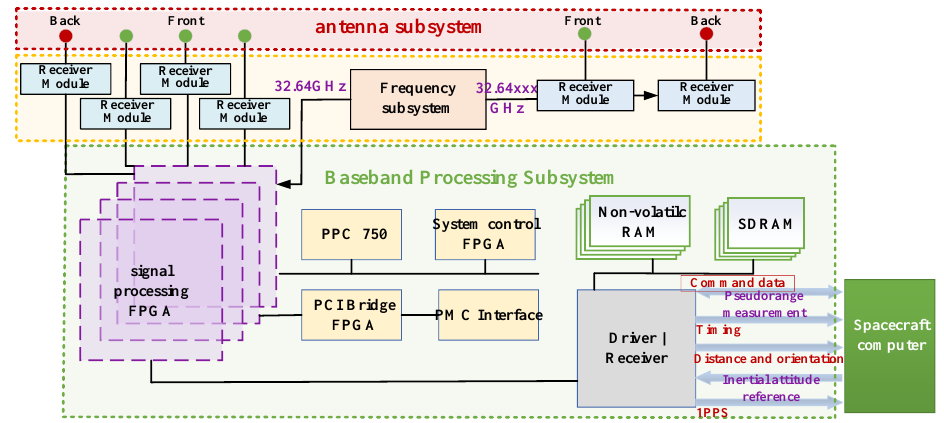
Figure 16. The AFF subsystem schematic diagram.